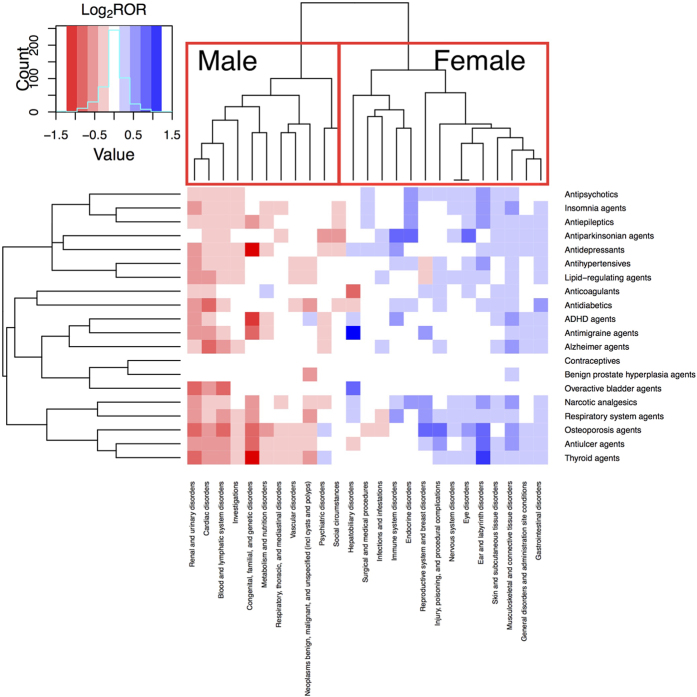
Heat Map of Sex Differences in drug-event combinations of 20 Treatment Regimens at the System Organ Class Category Level.Heat map shows positive signals of sex differences. The color of each cell is based on the logarithmic reporting odds ratio (ROR) for occurrence of drug-event combinations in the sex; blue cell represents the log2 ROR > 0, red cell represents the log2 ROR < 0; the darker the color, the greater the absolute value of ROR. P values were calculated using a proportion test and were adjusted by Bonferroni correction. Only drug-event combinations with sex differences significant at P ≤ .05 were selected. ADHD indicates attention-deficit/hypersensitivity disorder; incl, including.